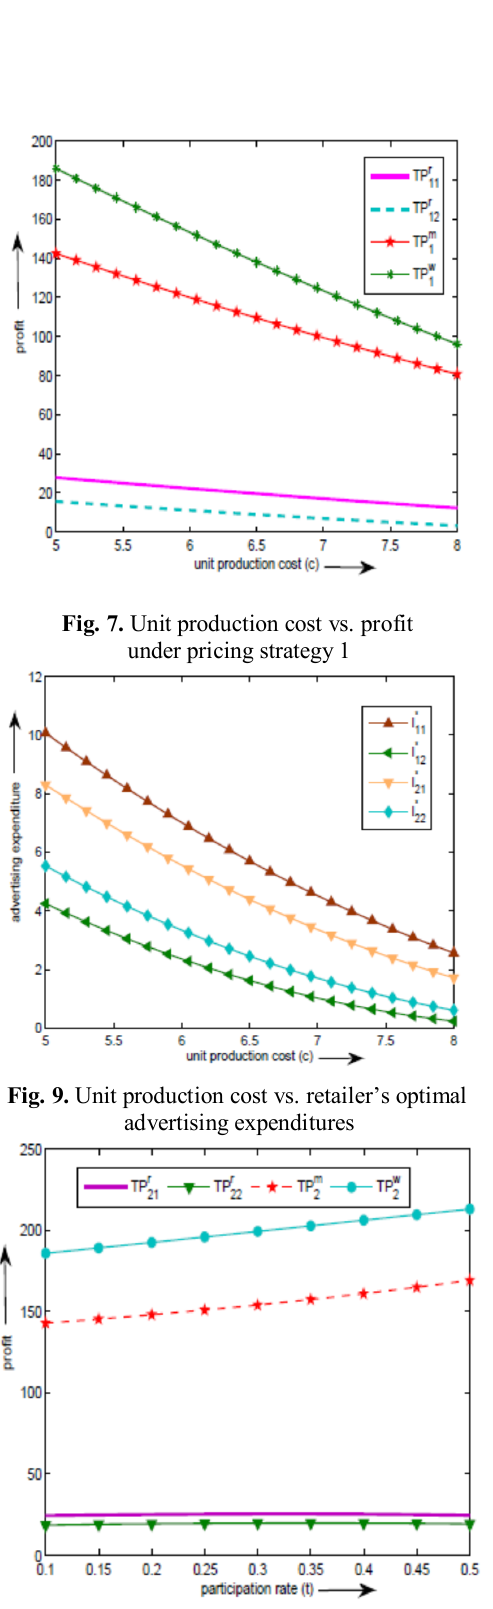
Fig. 12. Participation rate vs. retailers’ optimal advertising